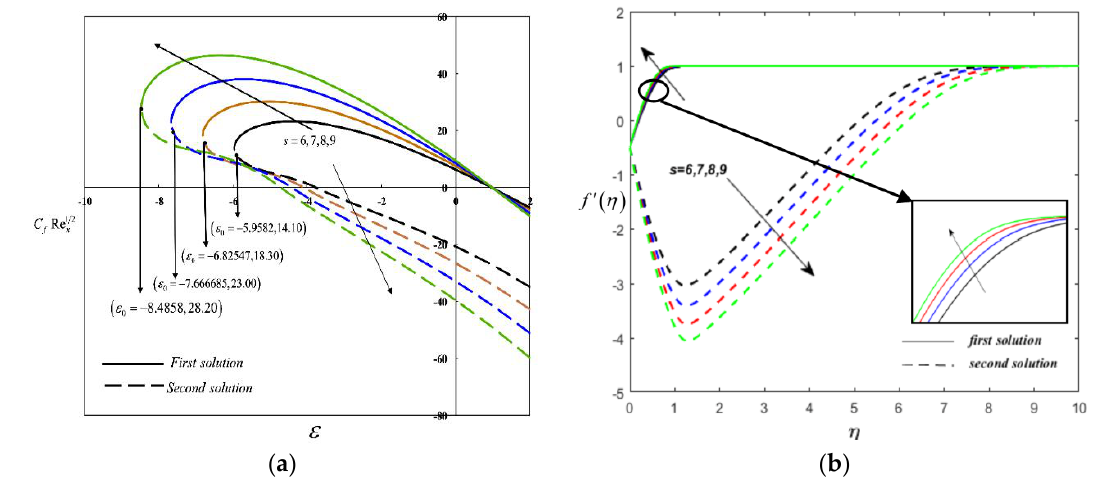
Figure 2. Impact of the suction parameter ( s ) on: ( a ) the reduced skin friction coefficient; ( b ) velocity profiles as s varies when Rd = 1.2, m 0 = 1.5,Pr = 4.36, De = 1.5, M = 0.5, and φ = 0.02.